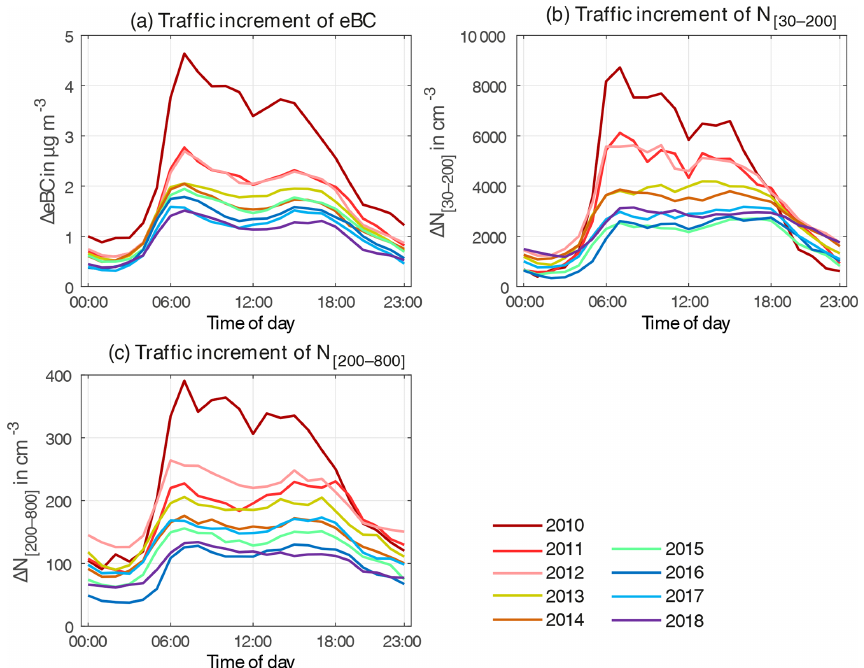
Figure 7. Average diurnal cycles of the increment of eBC mass concentration ( (cid:49) eBC, panel a ), N [ 30 − 200 ] ( (cid:49)N [ 30 − 200 ] , panel b ), and N [ 200 − 800 ] ( (cid:49)N [ 200 − 800 ] , panel c